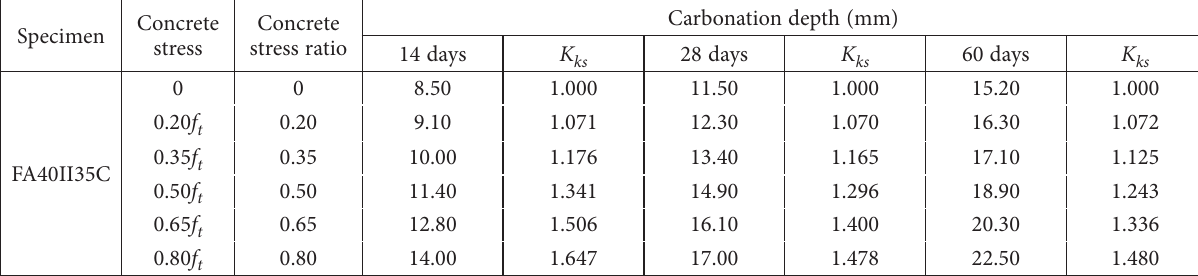
Table 2. Carbonation depths of specimens under different concrete stress conditions (data from Zhang et al., 2007) Specimen